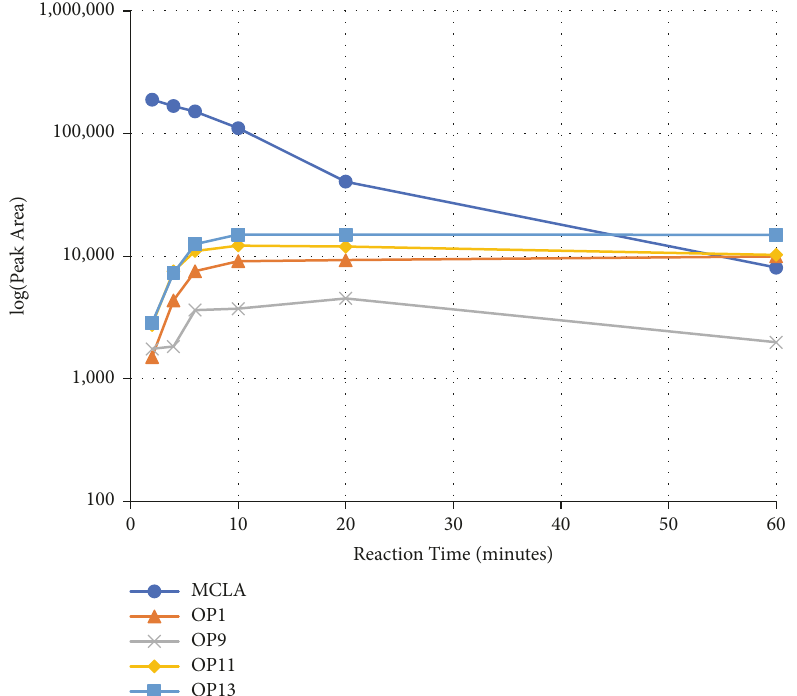
Figure 6: MC-LA major oxidation products formed via reaction with 2.0 ppm permanganate at 22 ∘